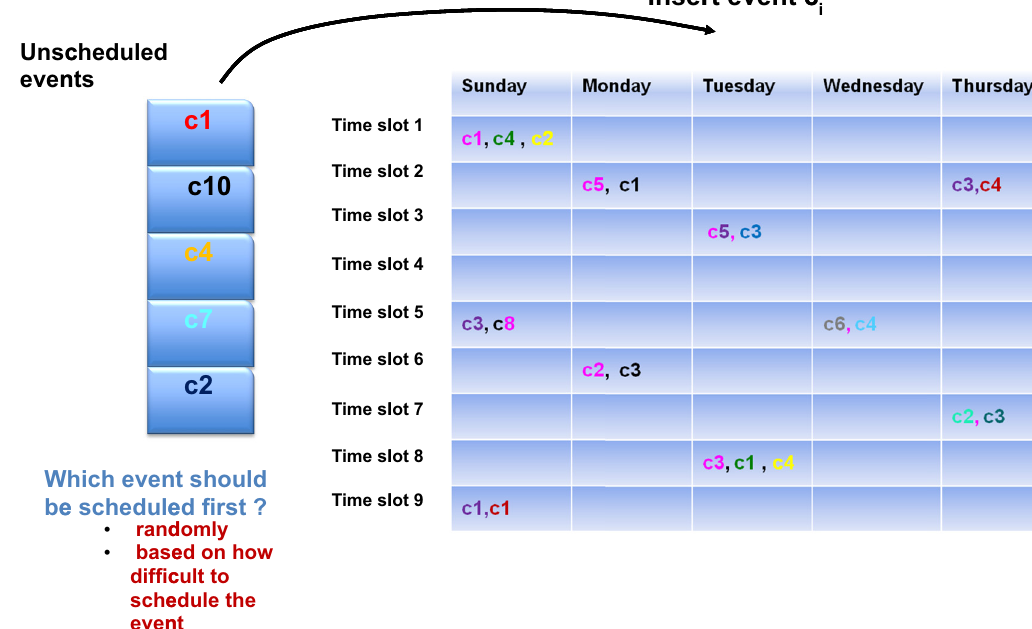
Figure 1: Constructive heuristics ( the least saturation degree )